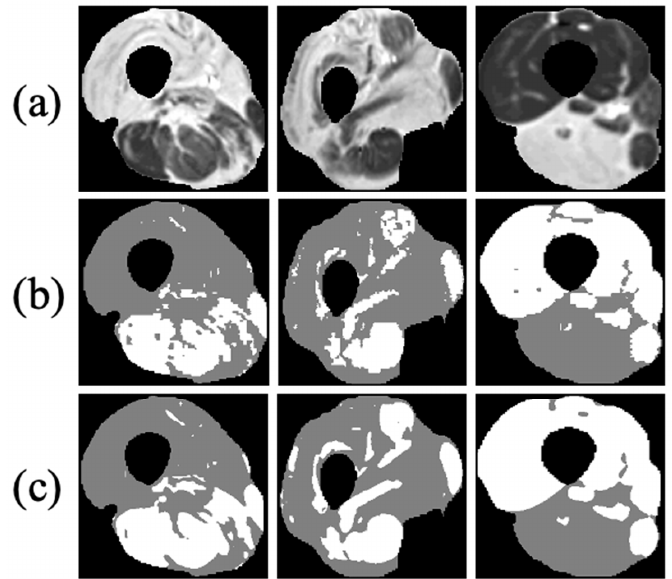
Figure 8. Three examples of FCN-based classification of thigh anatomy: ( a ) axial MR images of three different patients after applying the first stage of the proposed method and segmenting the muscle region; ( b ) ground truth of the intermuscular adipose tissue ( IMAT ) and viable muscle pixels within the muscle region (white: viable muscle: gray: IMAT pixels); ( c ) tissue classification using the suggested FCN